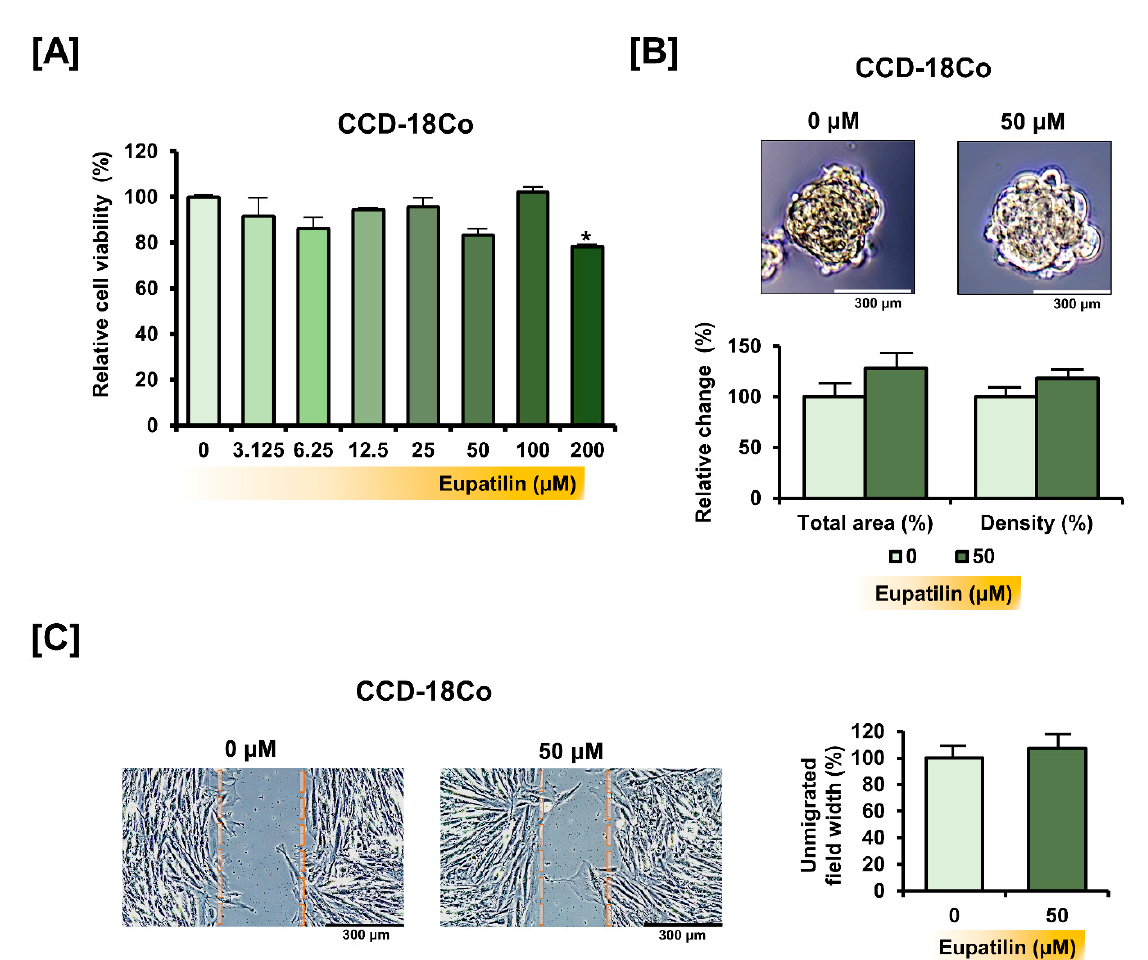
Figure 8. Effect of eupatilin in normal colon cancer cells. ( A ) Dose-dependent effects of eupatilin on CCD-18Co cell viability ( B ) Bright field images showing the changes in spheroid morphology following eupatilin treatment. The total area and density of the spheroid were calculated using the ImageJ software. ( C ) Migration of CCD-18Co cells in response to eupatilin calculated based on gap distance. Asterisks indicate a significant change after eupatilin treatment (* p < 0.05).